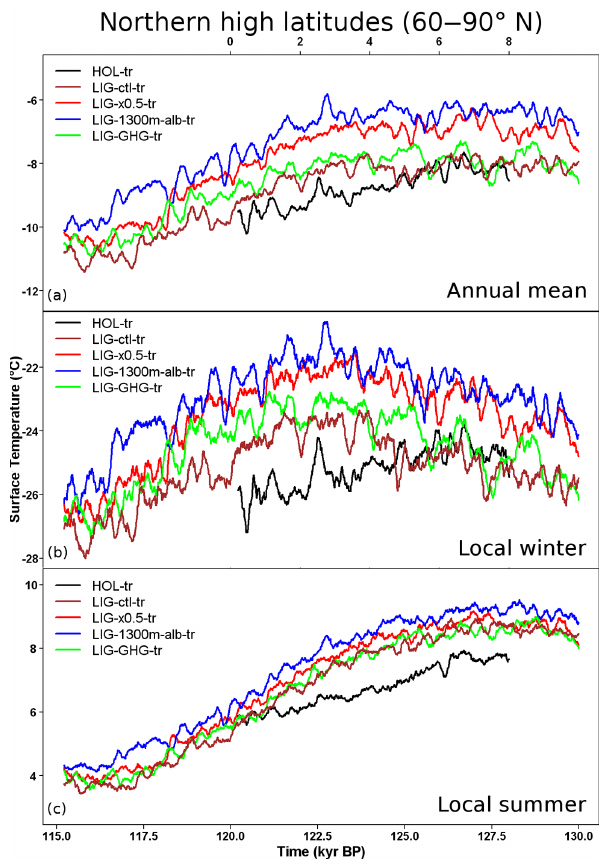
Figure 5. Simulated surface temperature evolution for the Last In- terglacial (LIG-_) and the Holocene (8–0kyrBP, HOL-tr) in north- ern high latitudes (60–90 ◦ N) calculated as a running average with a window length of 21 model years representing 210 calendar years for (a) annual mean, (b) local winter mean (coldest month), and (c) local summer mean (warmest month). The lower x scale rep- resents the LIG timescale, while the upper x scale indicates the Holocene timescale. The upper x scale is matched to the timescale between 128 and 120kyrBP, assuming that Termination I and Ter- mination II are similar with respect to obliquity (Drysdale et al.,